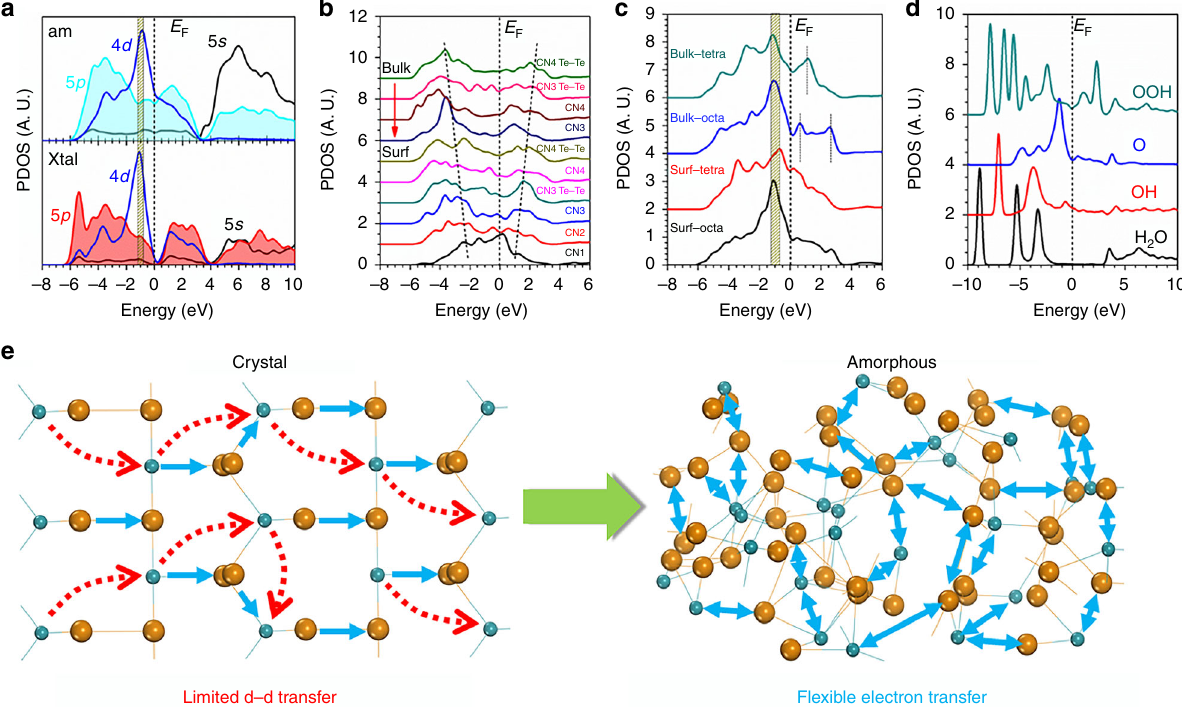
Flexible electron Fig. 2 Electronic activities of the amorphous RuTe 2 for OER. a PDOSs comparison between amorphous and crystalline RuTe 2 systems. b Site-dependent PDOSs variation trend of Te-5p band. c Site-dependent PDOSs variation of Ru-4d band. d Individual PDOSs contributions of O-species from OER process. e Schematic diagram of the electronic activity enhancement in amorphous structure. The stronger electron transfer between p-d than the p-p also in the amorphous structure. The distorted Ru-Te lattice increases supports the anti-oxidation of the RuTe 2 . The enhanced bonding the homogeneity for ef fi cient inter-d-orbital electron-transfer and anti-bonding splitting effect of Te-5p band in the bulk region ability among Ru sites (Fig. 2a). The surface Te-5p dominantly with higher CN results in gradually inert and less overlapped with occupies from E V − 4.5 eV to E F with the most overlapping with Ru-4d (Fig. 2b). The surface Ru-4d band obviously merges the Ru-4d, enhancing the activities of p-d coupled electron-exchange. NATURE COMMUNICATIONS| (2019) 10:5692